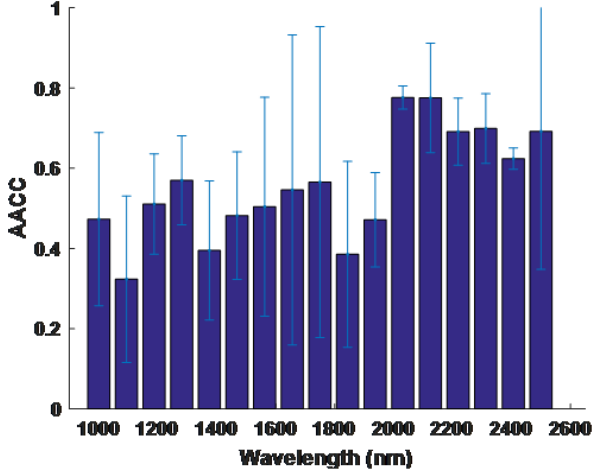
Fig. 8. Absolute averaged correlation coe±cient (AACC) against wavelength for the sub-bands.